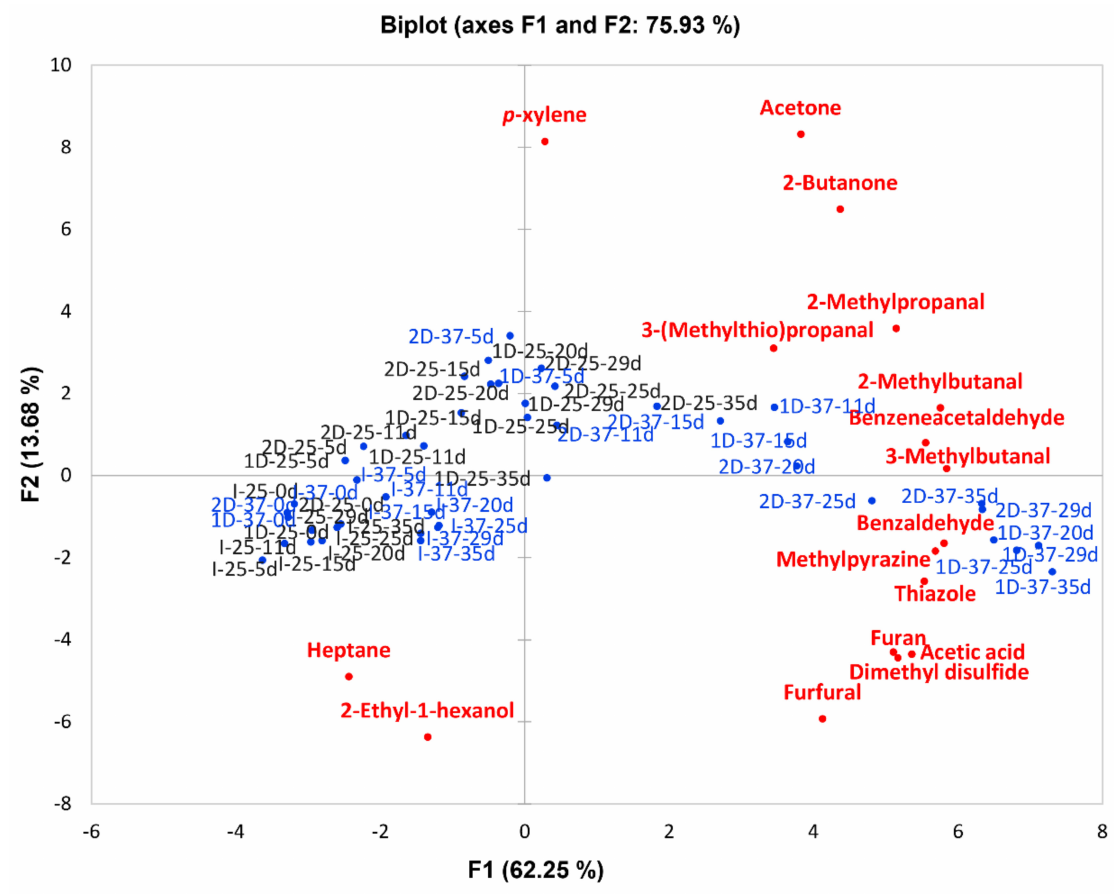
Figure 4. Loadings of the first two principal components (PC1-PC2) representing the variability (volatile compounds) in the model systems simulating the dry curing stages (I-Initial stage, 1D-1st drying stage, 2D-2nd drying stage). Sample loadings in black and blue represent models incubated at 25 and 37 ◦ C,